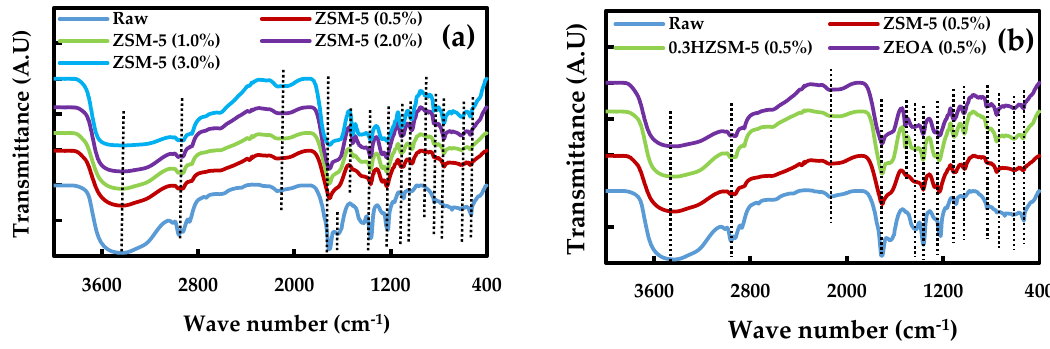
Figure 6. Averaged FTIR spectra ( a ) auto-smoothed and ( b ) auto-baseline corrected) of bio-oil samples.